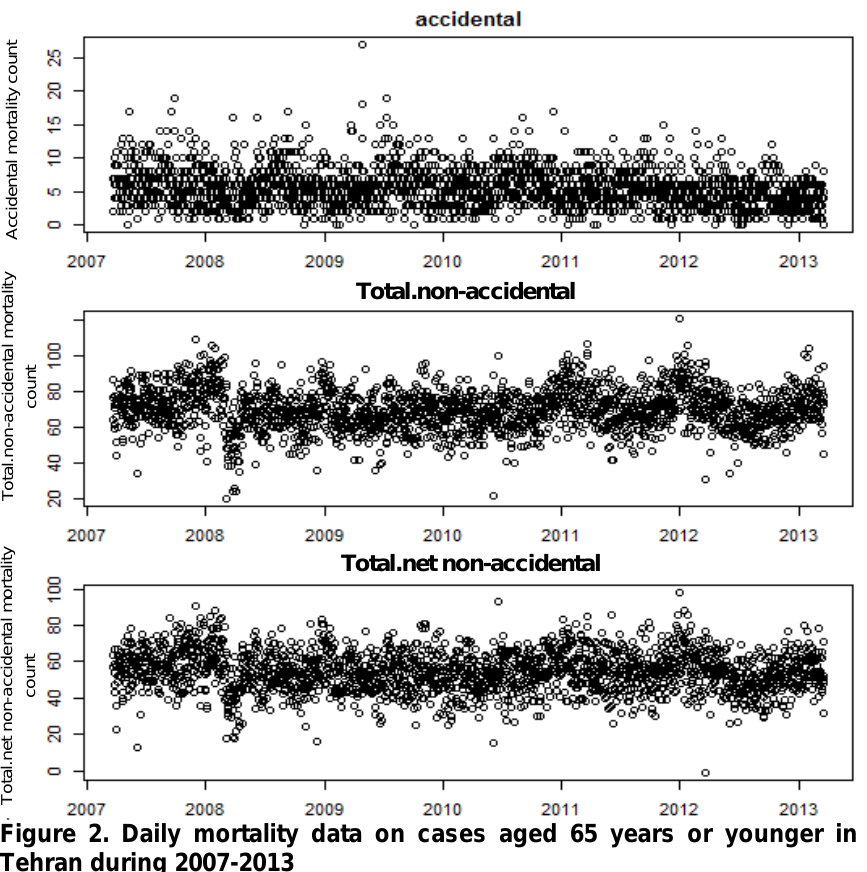
Figure 2. Daily mortality data on cases aged 65 years or younger in Tehran during 2007-2013